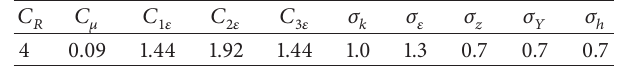
Table 1: Constants of standard 𝑘 - 𝜀